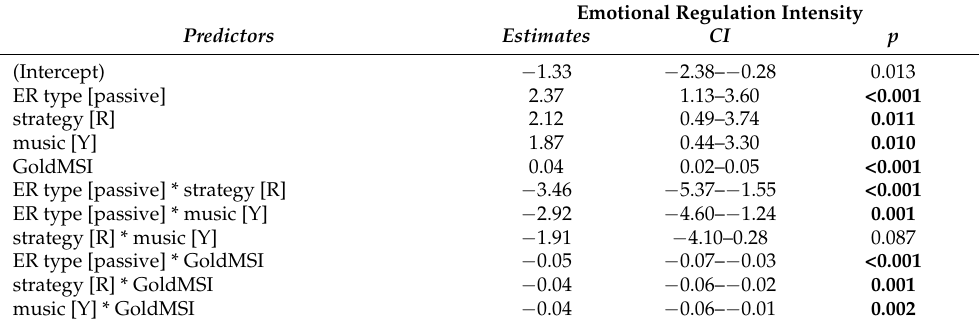
Table A1. Effects of ER type, music, strategies and Gold-MSI on emotional regulation